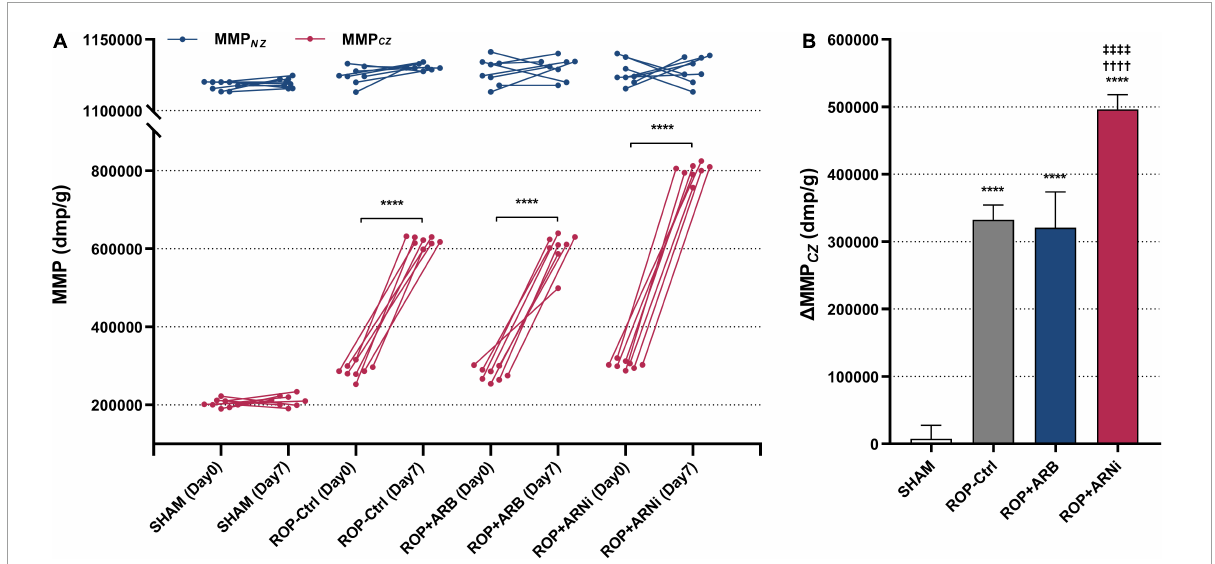
FIGURE3 Measurement of myocardial collateral perfusion. MMP, microspheres-based myocardial perfusion; MMP CZ , MMP of CZ; MMP NZ , MMP of NZ; (cid:49) MMP CZ , difference value of MMP CZ at Day 7 and Day 0. (A) Microspheres-based myocardial perfusion at Day 0 and Day 7. Blue lines indicate changes of MMP NZ from Day 0 to Day 7, red lines indicate the changes of MMP CZ from Day 0 to Day 7. ∗∗∗∗ P ≤ 0.0001, compared to Day 0. (B) Difference value of MMP CZ among groups. ∗∗∗∗ P ≤ 0.0001, compared to SHAM, †††† P ≤ 0.0001, compared to ROP-Ctrl, ‡‡‡‡ P ≤ 0.0001, compared to ROP+ARB.